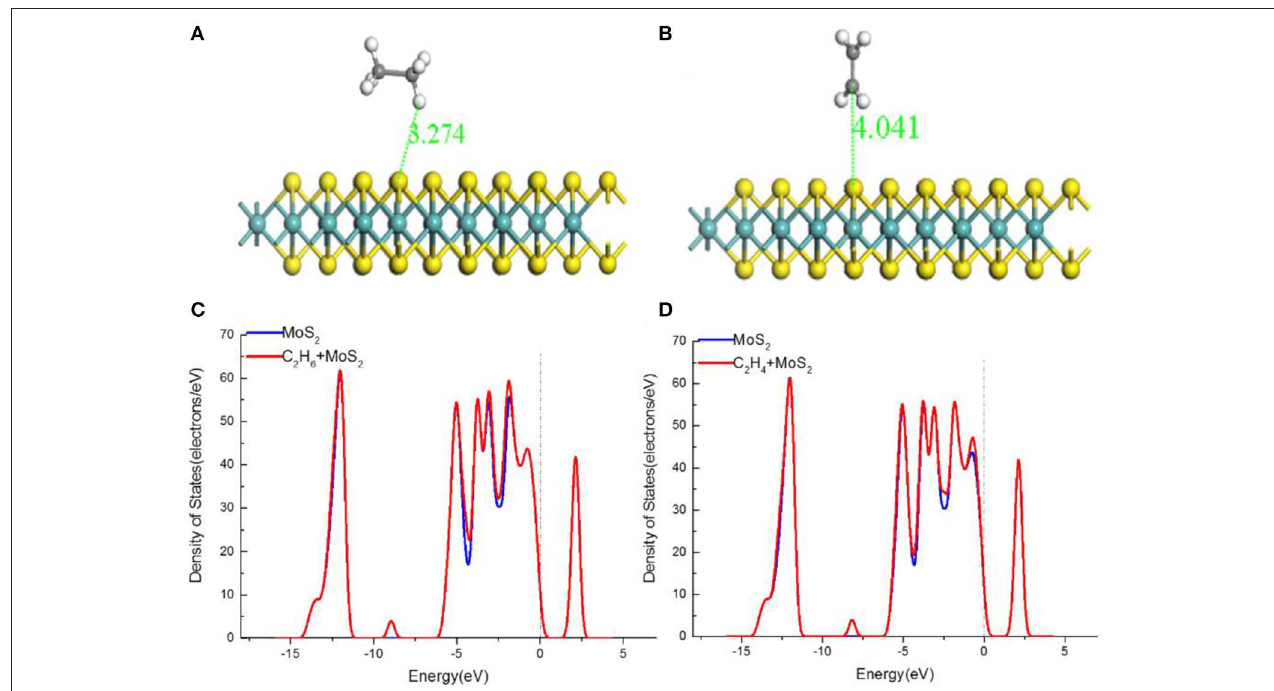
FIGURE 3 | The structures of MoS 2 monolayer of (A) C 2 H 6 -adsorbed MoS 2 monolayer, (B) C 2 H 4 -adsorbed MoS 2 monolayer and the TDOS of (C) C 2 H 6 -adsorbed MoS 2 monolayer, (D) C 2 H 4 -adsorbed MoS 2 monolayer.